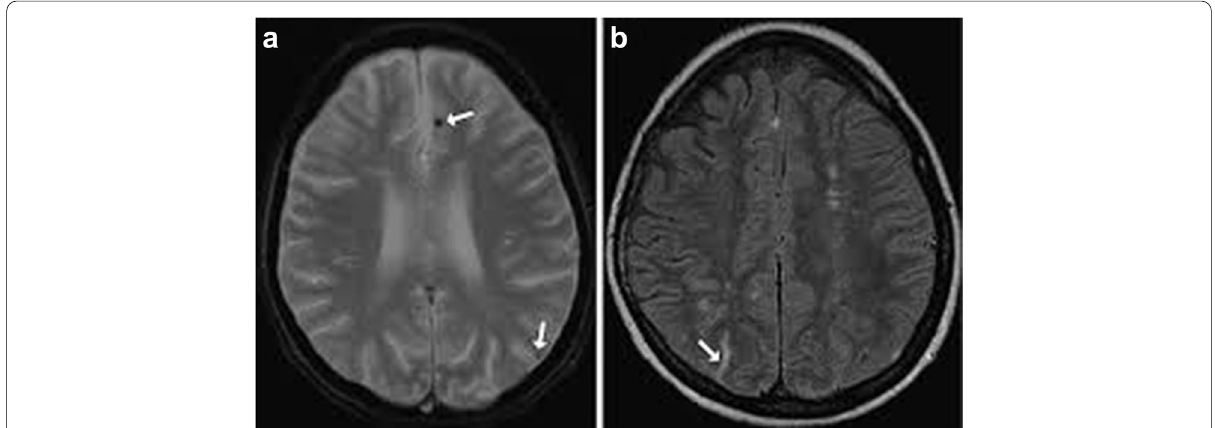
Fig. 1 Brain MRI findings in SLE: hyperintense foci without any restriction of diffusion or any evidence of hemorrhage. They may represent vasculitic changes in the white